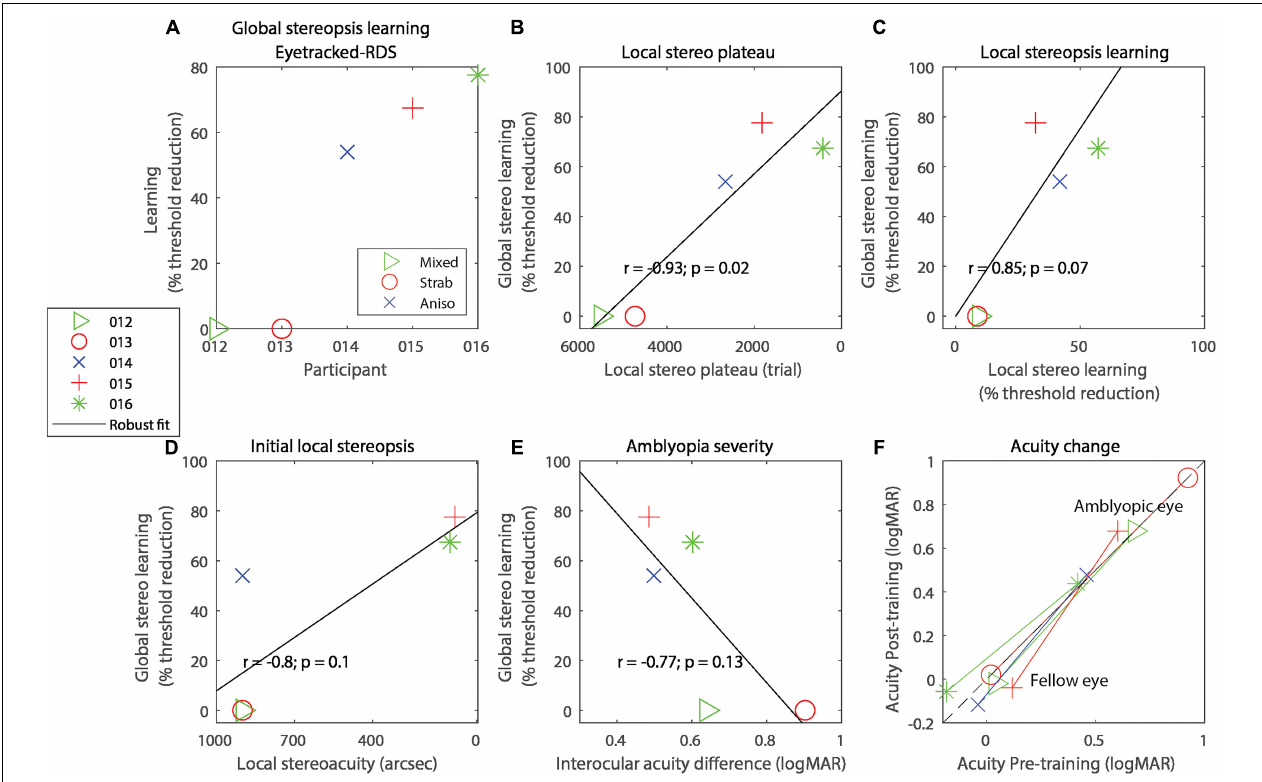
FIGURE 2 | (A) Global stereo learning, expressed as percent threshold reduction on the Eyetracked RDS test for each of the participants. On all panels, symbols code for the participant and colors code for the type of amblyopia. (B) Correlation between global stereo learning and local stereo plateau trial number. (C) Correlation between global stereo learning and local stereo learning. (D) Correlation between global stereo learning and performance on the local stereopsis task extrapolated to trial 1. (E) Correlation between global stereo learning and amblyopia severity (defined as the interocular acuity difference). (F) Visual acuity change with training, expressed in logMAR. Lines connect each eye’s acuity values for the same participant. Data points below the black diagonal dashed line indicate improvement in visual acuity with training. In panels (B–E) , the solid diagonal black line represents a robust linear regression following an iteratively reweighted least-squares technique with a bisquare weighting